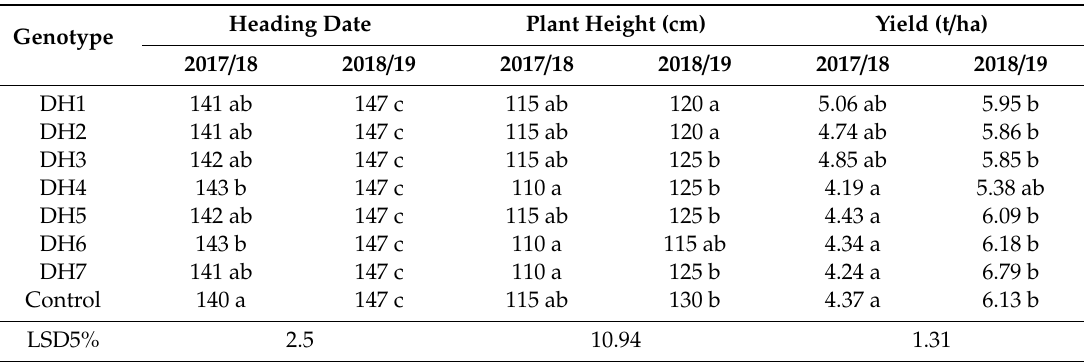
Table 10. Heading date, plant height, and yield parameters of ‘Tonkoly.pop1’ advanced line (Control) and its doubled haploid (DH) lines based on field experiment in two consecutive years. Values with the same capital letters are not significantly di ff erent ( p >